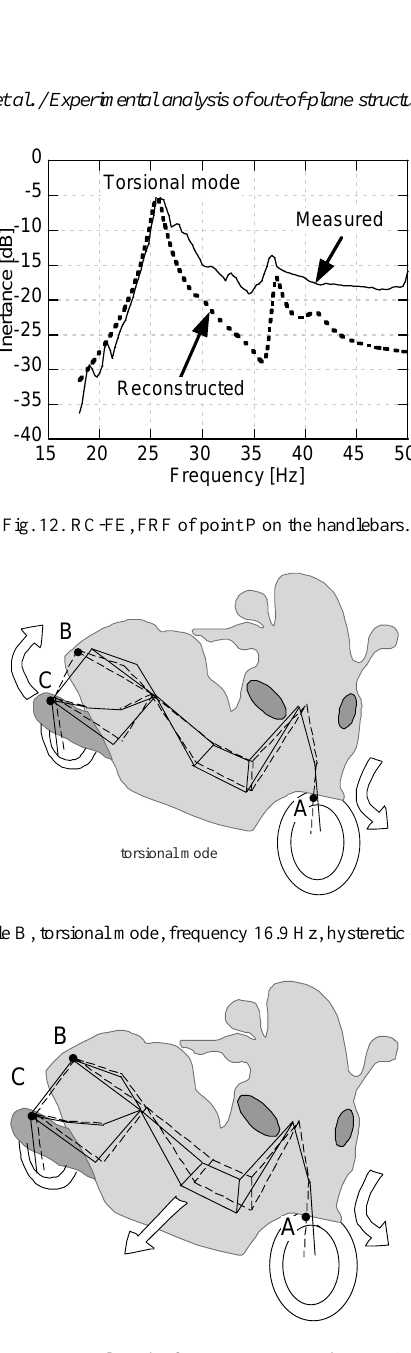
Fig. 14. Vehicle B, structural mode, frequency 19.7 Hz, hysteretic damping